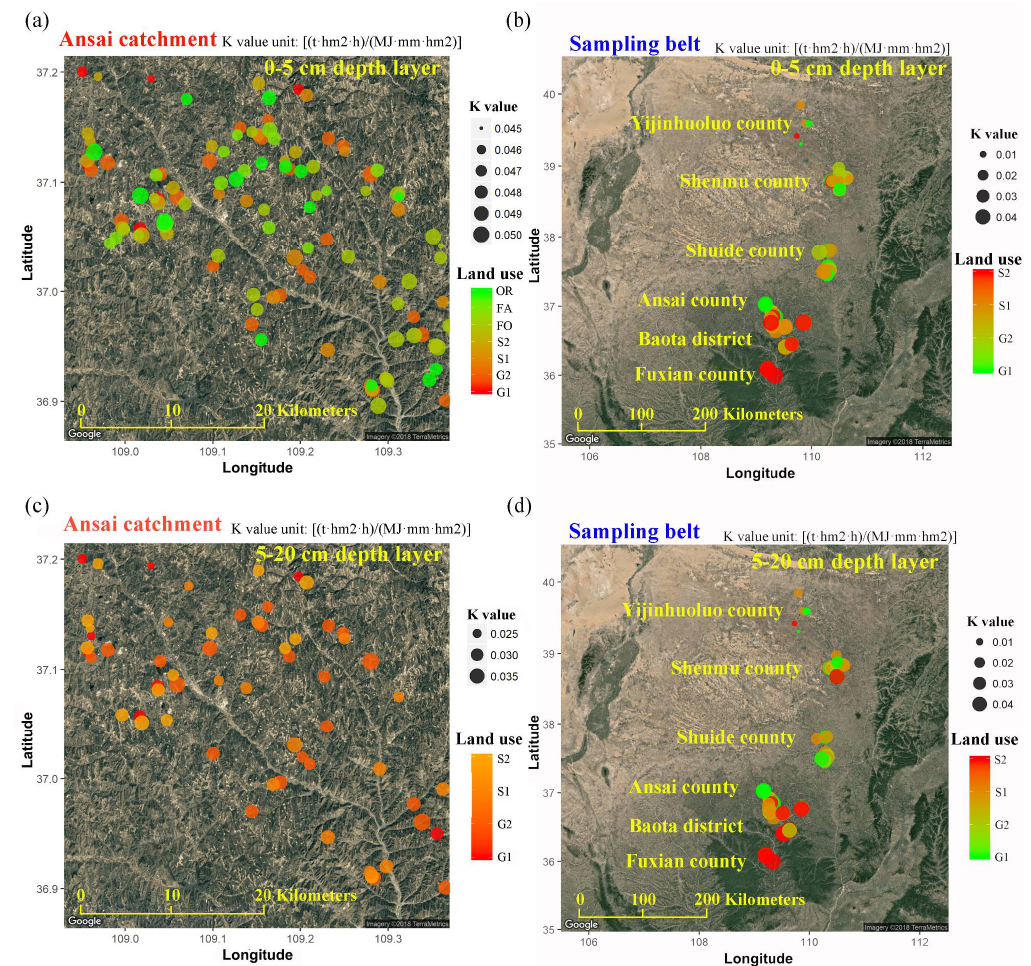
Figure 4. The distribution of K values at catchment (( a ) for 0–5 cm depth layer and ( c ) for 5–20 cm depth layer) and region scale (( b ) for 0–5 cm depth layer and ( d ) for 5–20 cm depth layer) by using the SHIRAZI model. G1 represents introduced grassland; G2 represents natural grassland; S1 represents introduced shrubland; S2 represents natural shrubland; FO represents forest; FA represents farmland; OR represents orchard; the different colors of bubbles represent different dominant species; the size of the bubbles represents the K value. Table 3. The mean value of K at catchment scale (t · hm 2 · h/(MJ · mm · hm 2 )). Depth G1